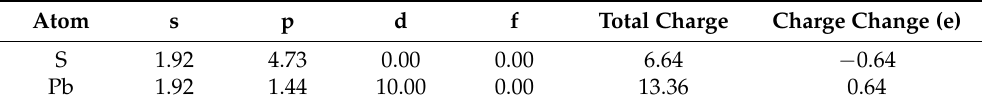
Table 4. Mulliken atomic population analysis of